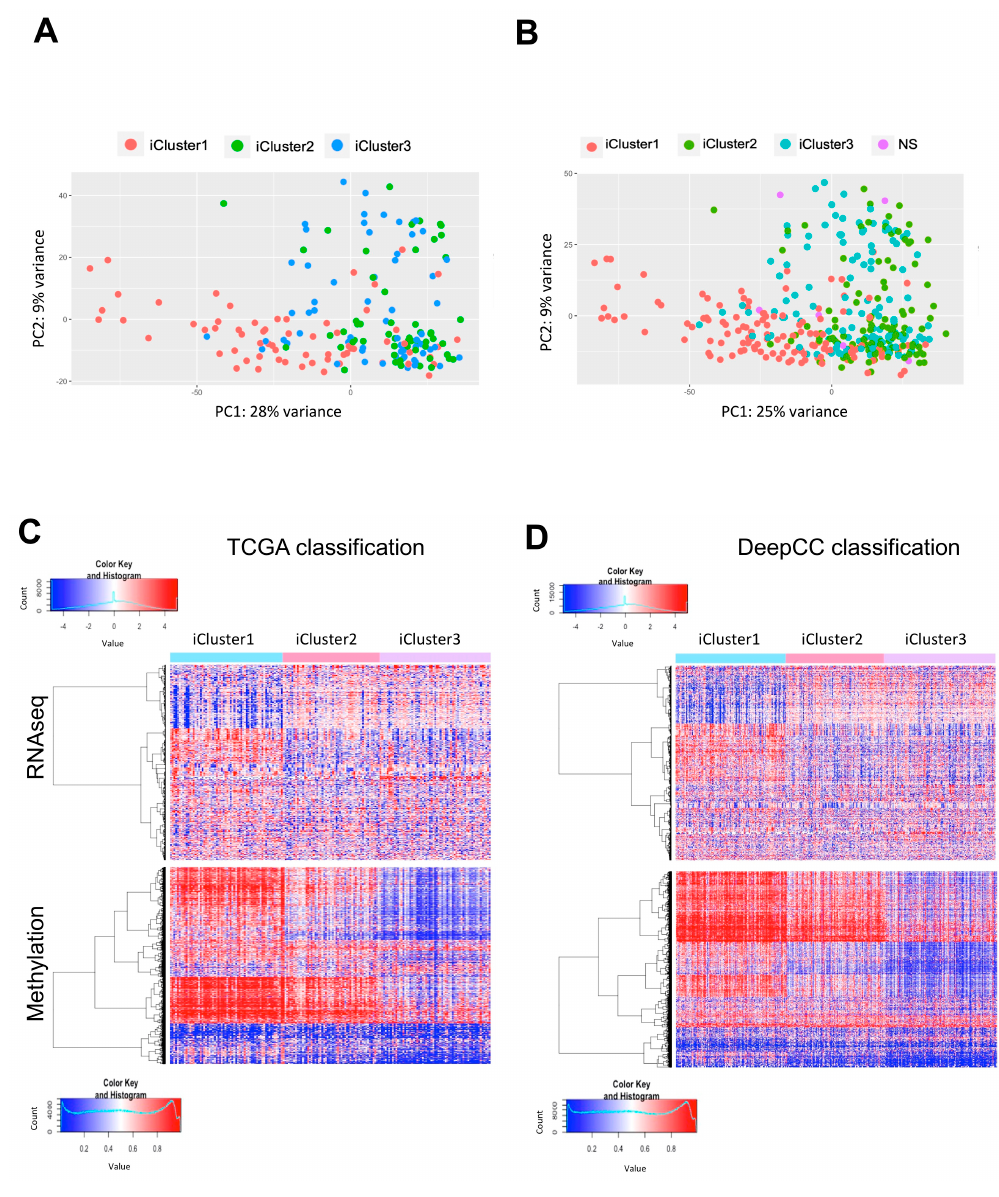
Figure 3. Partitioning of all TCGA HCC tumors in iClusters. ( A ) Principal Component Analysis of 183 tumor samples previously categorized by TCGA. ( B ) Principal Component Analysis (PCA) of all the 373 tumor samples partitioned in subtypes through DeepCC. ( C ) Gene mRNA expression (upper panel) and methylation profile (lower panel) in iClusters according to TCGA classification. ( D ) RNA-seq and methylation profile of DeepCC-derived iClusters. In both heatmaps, genes / methylation probes are rows and columns are tumor samples.